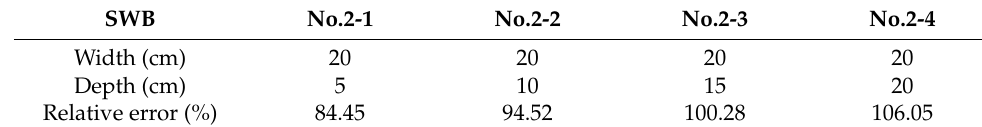
Table 2. The width relative error of SWBs of the same size (simulation scenario 3).